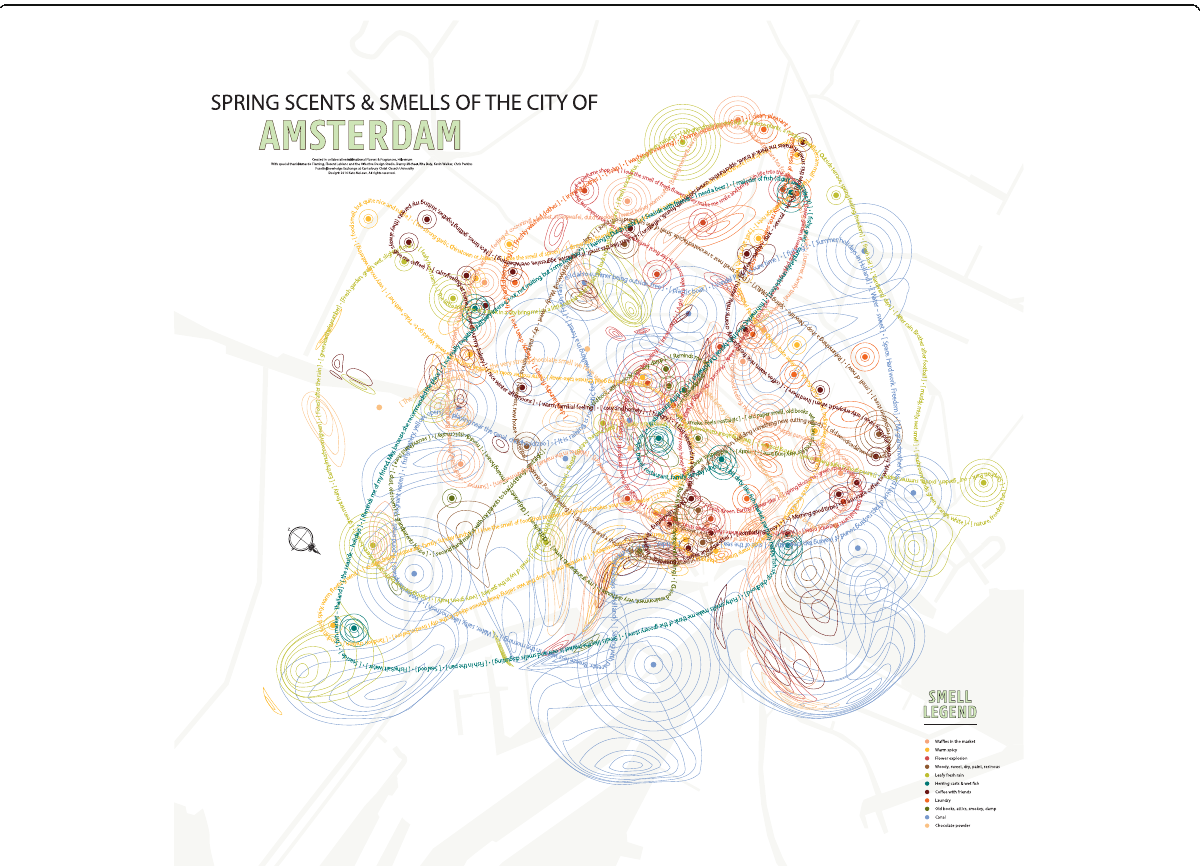
Fig. 6 Scentscape of the city. Spring scents and smells of the city of Amsterdam by Kate McLean. [Credit “ Spring Scents & Smells of the City of Amsterdam ” © 2013-2014. Digital print. 2000 x 2000 mm. Courtesy of Kate